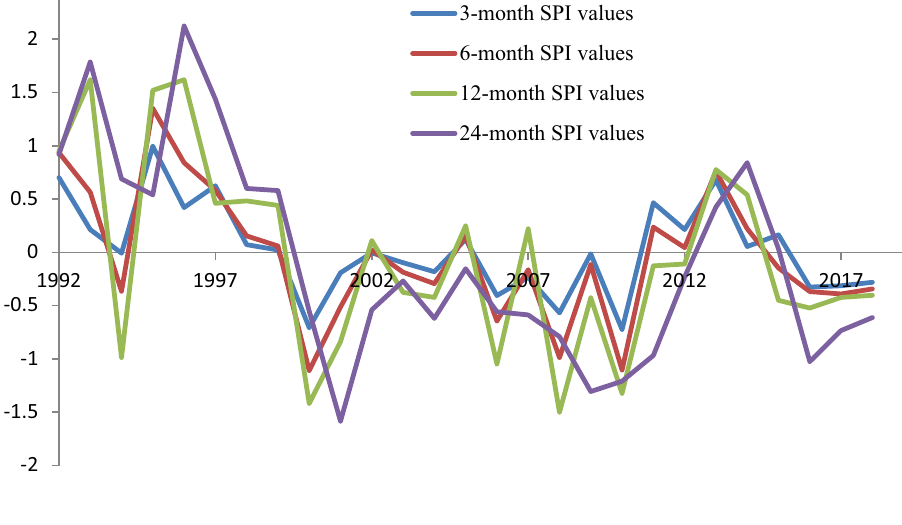
Fig. 4 The n -fold cross-valida- tion method scheme